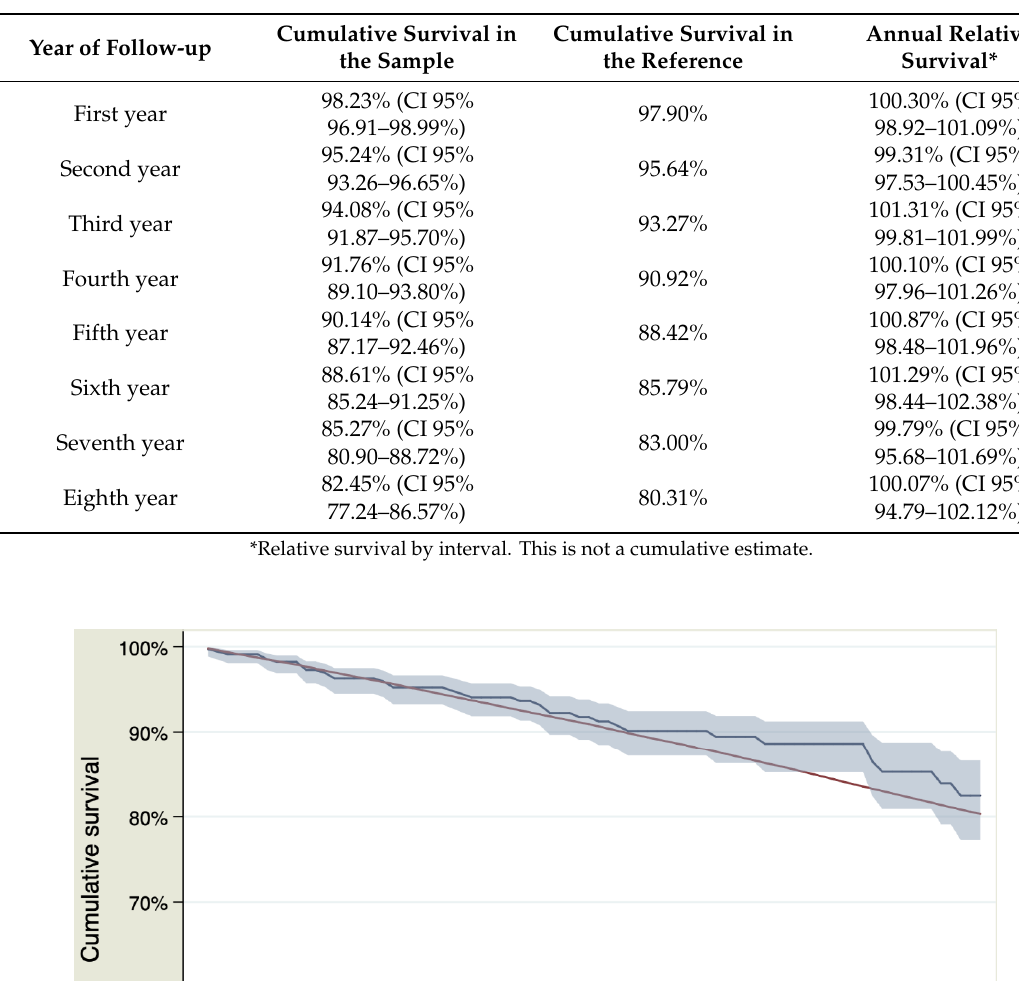
Table 5. Cumulative survival of the sample and the reference population. Annual relative survival is also described. Data for survivors of the postoperative period.